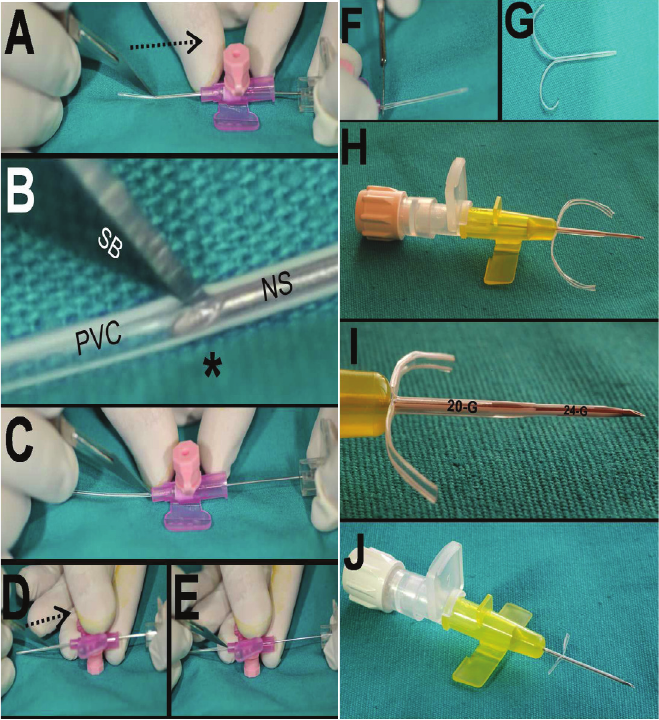
FIGuRE 1 - The preparation of the pre-cut-semi-split introducers for the 2-F ( A-I ) and 1-F (J) PICCs by using our technique ( Ns : Needle stylet, sB : Surgical blade, PVC : Peripheral venous cannula, G : Gauge, Asterisk : The sharp point hole of the needle stylet, Arrows : Direction of the sliding blade).160x497mm (150 x 150 DPI).